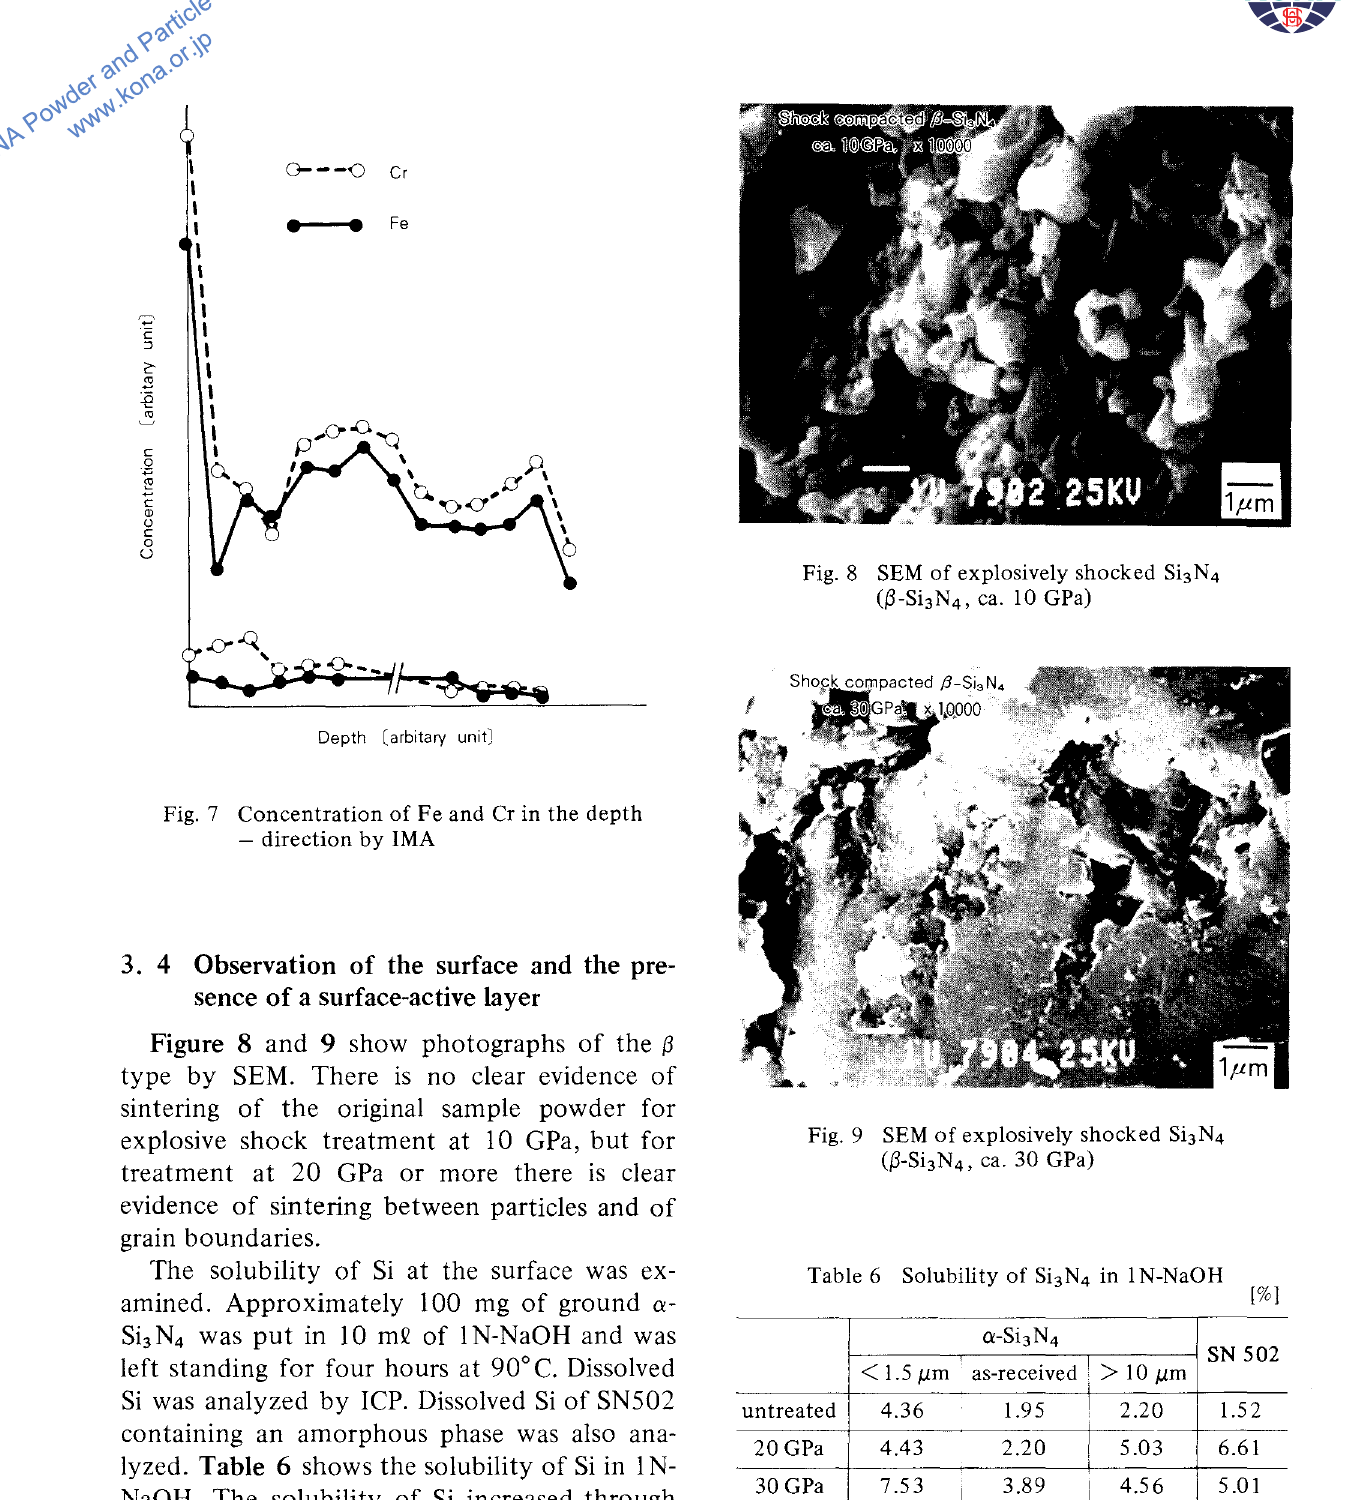
Fig. 8 SEM of explosively shocked Si3N4